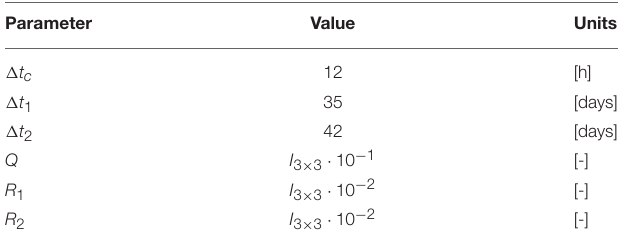
TABLE 10 | Standard deviations.